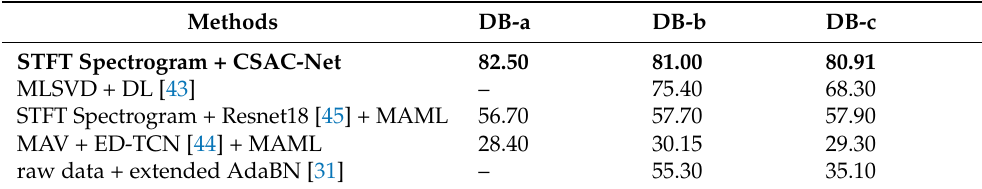
Figure 9. For different methods and datasets, the accuracy of 10 repetitions. Table 5. Comparison between previous methods and the proposed CSAC-Net in terms of the accuracy (%) of inter-subject classification on DB-a, DB-b, and DB-c (10 times average accuracy). The boldface number represents the best classification